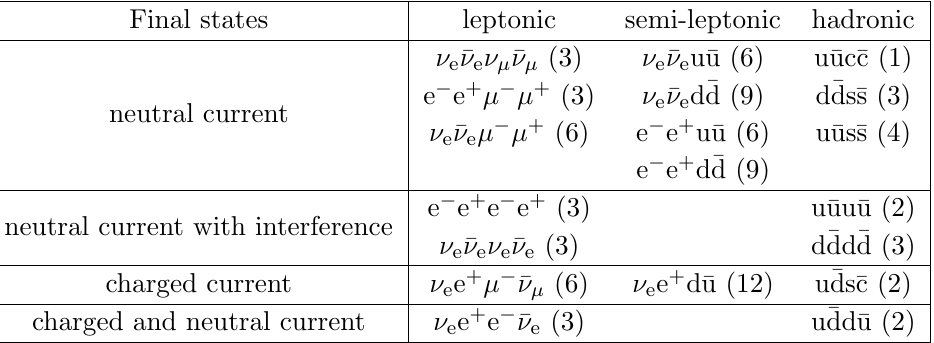
Table 1 . Classi(cid:12)cation of the possible (cid:12)nal states for the decays h ! WW = ZZ ! 4 f . Final states that di(cid:11)er only by generation indices, but have the same diagrams, are only stated once. The numbers in parentheses are the numbers of inequivalent (cid:12)nal states that are represented by the given